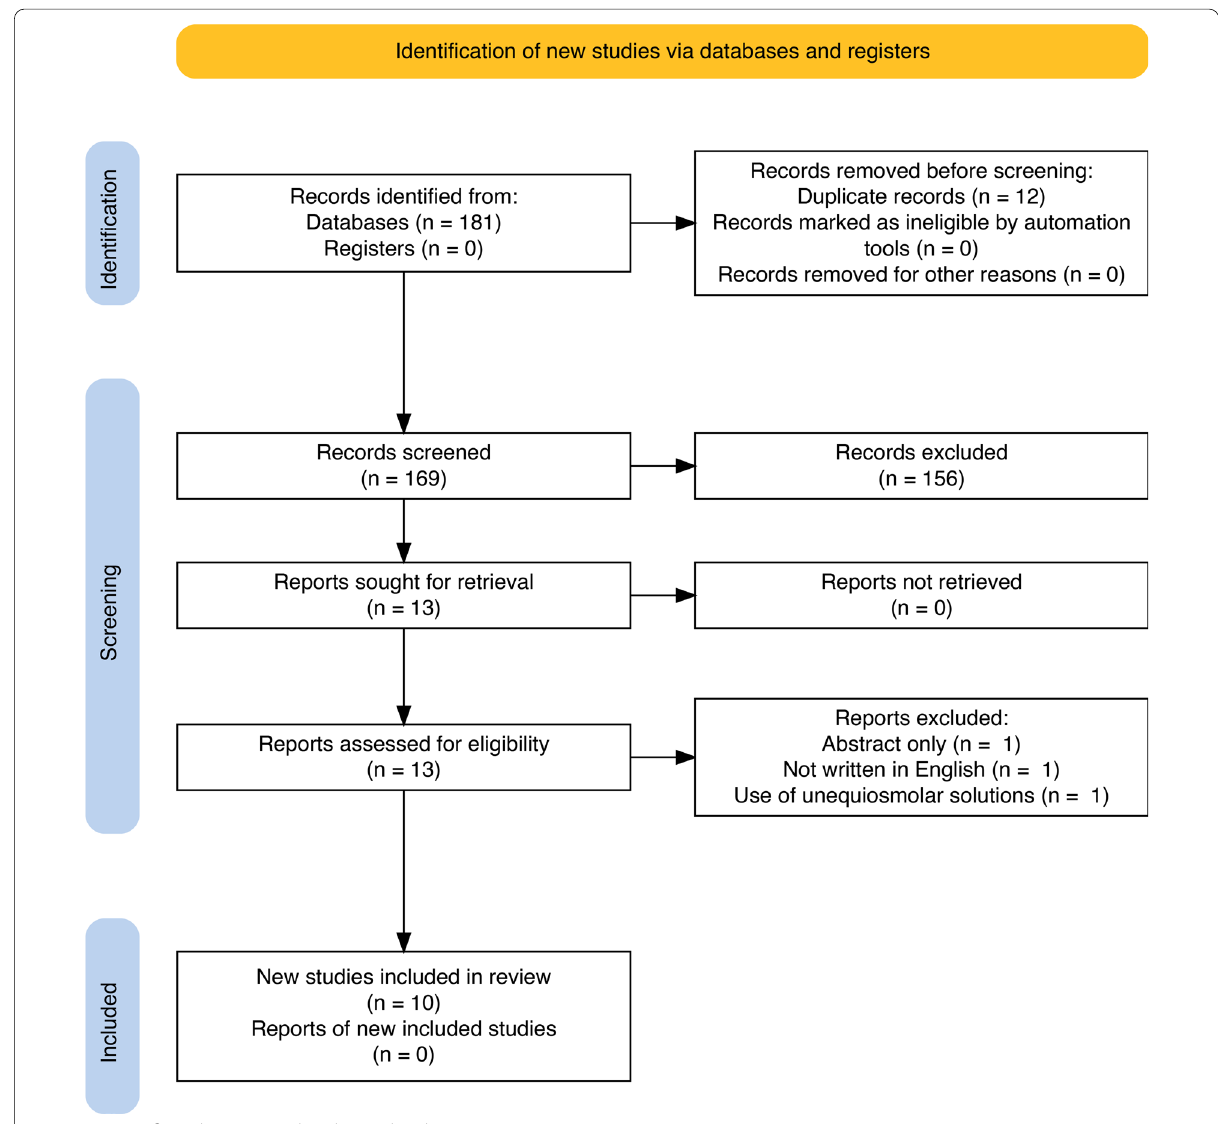
Fig. 1 PRISMA flow chart to visualize the study selection